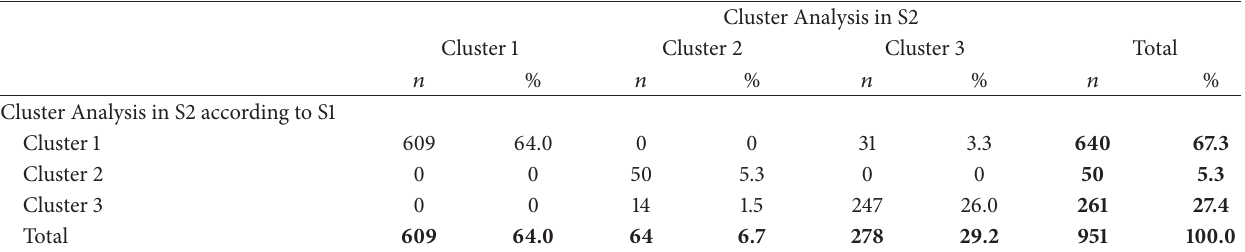
Table 4: Distribution of the subjects (training and testing datasets) during cross-validation process.